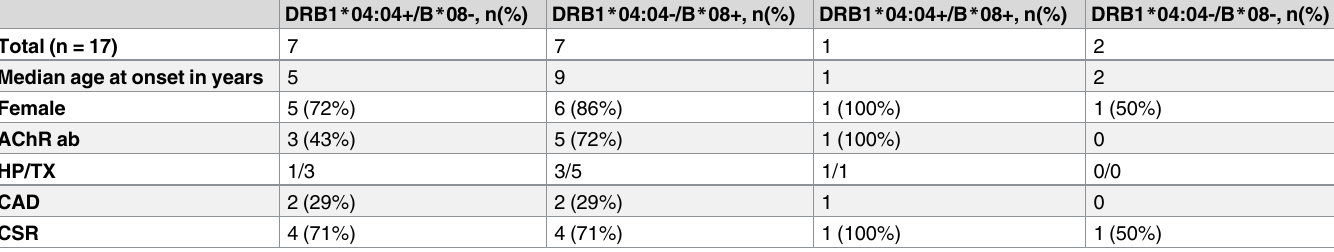
Table 4. Clinical characteristics of prepubertal onset myasthenia gravis stratified by HLA